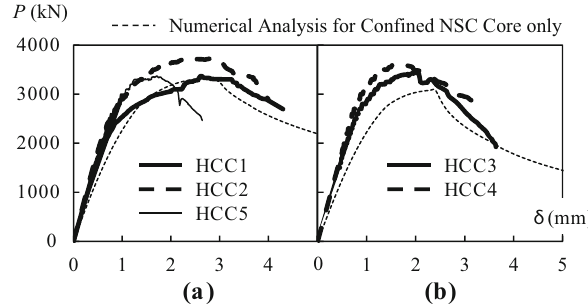
Fig. 10 Comparison of test results with numerical analysis for confined NSC core only: a s = 100 mm and b s = 200